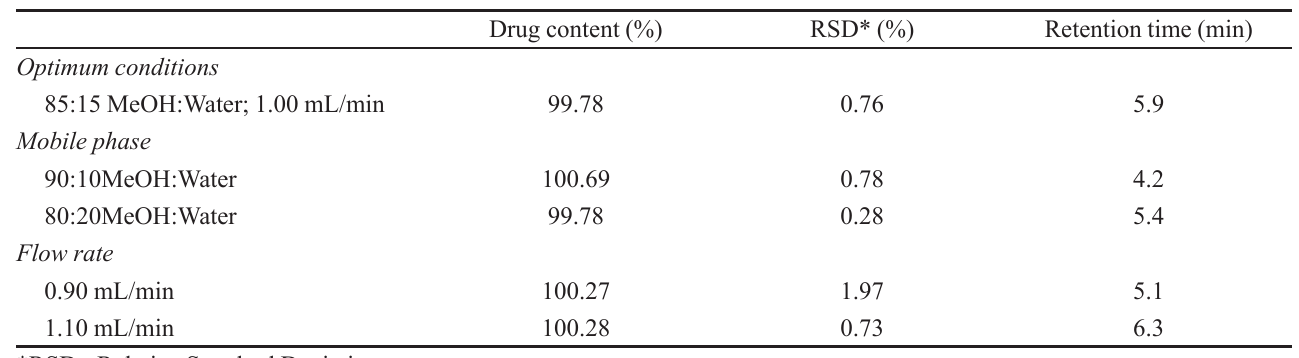
TABLE II - Robustness data for beclomethasone dipropionate analysis ( n =3)